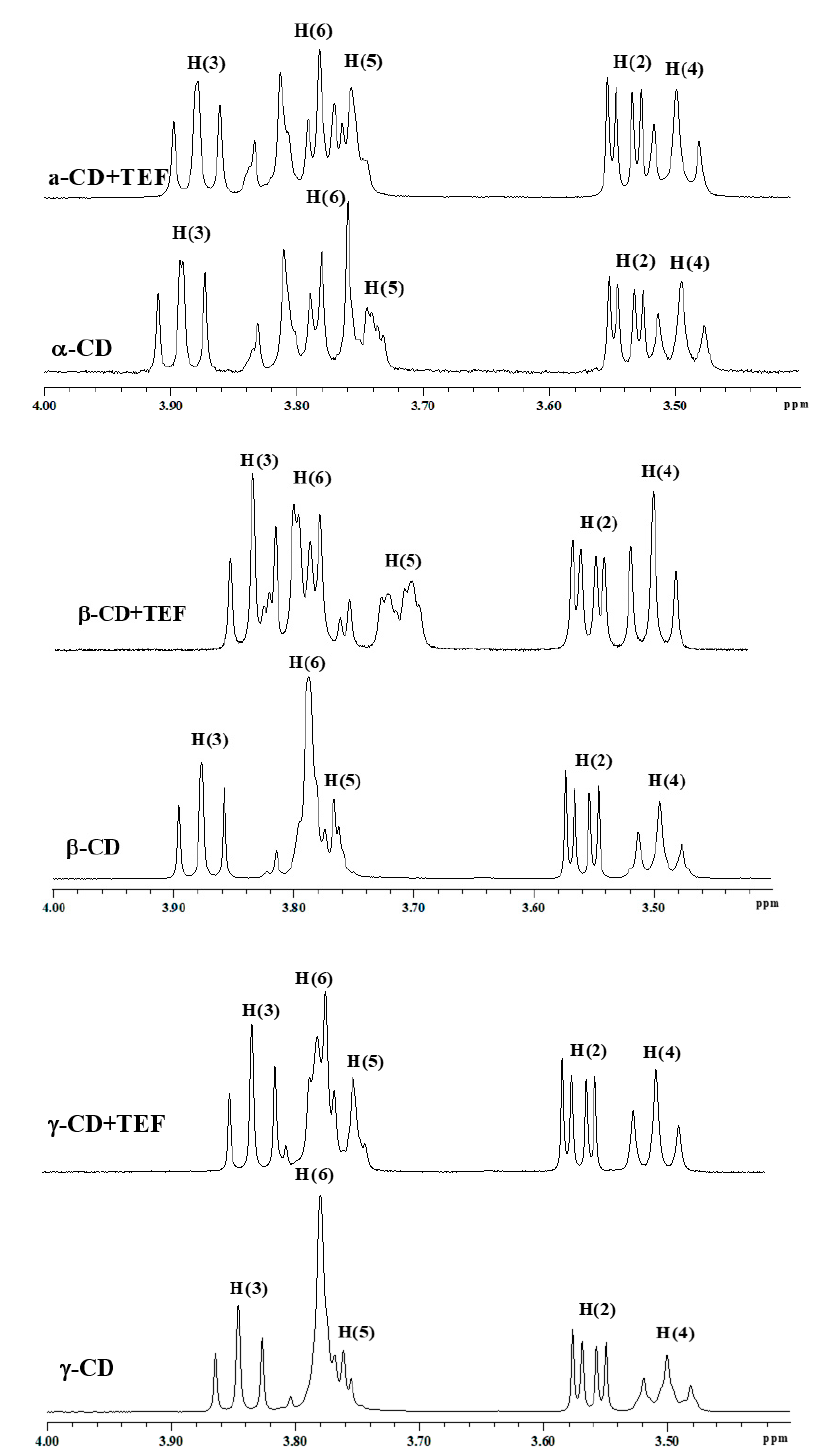
Figure 3. Fragments of 1 H NMR spectra of CDs with and without TEF in phosphate buffer (pD 7.4) at 298.15 K.